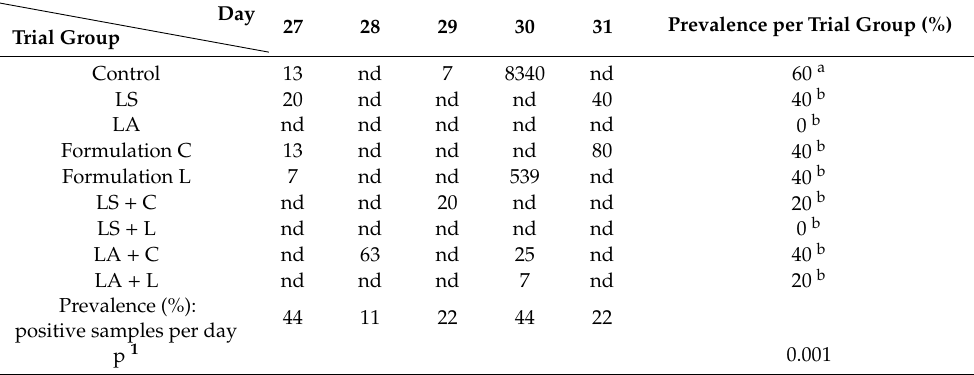
Table 5. Impact of probiotic and phytobiotic feed additives on the prevalence of ESBL-producing Enterobacteriaceae in cecal contents of broilers [cfu /